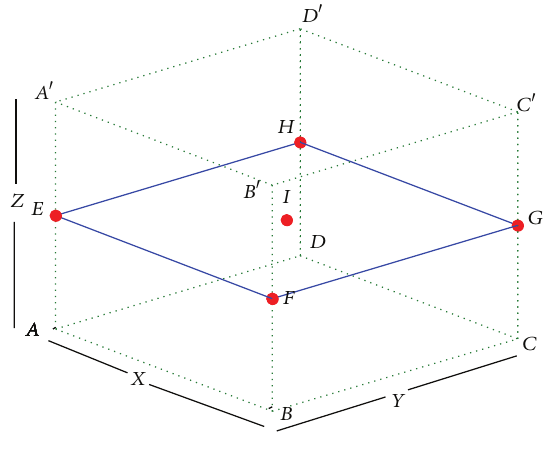
Figure 1: Coverage pattern Ω